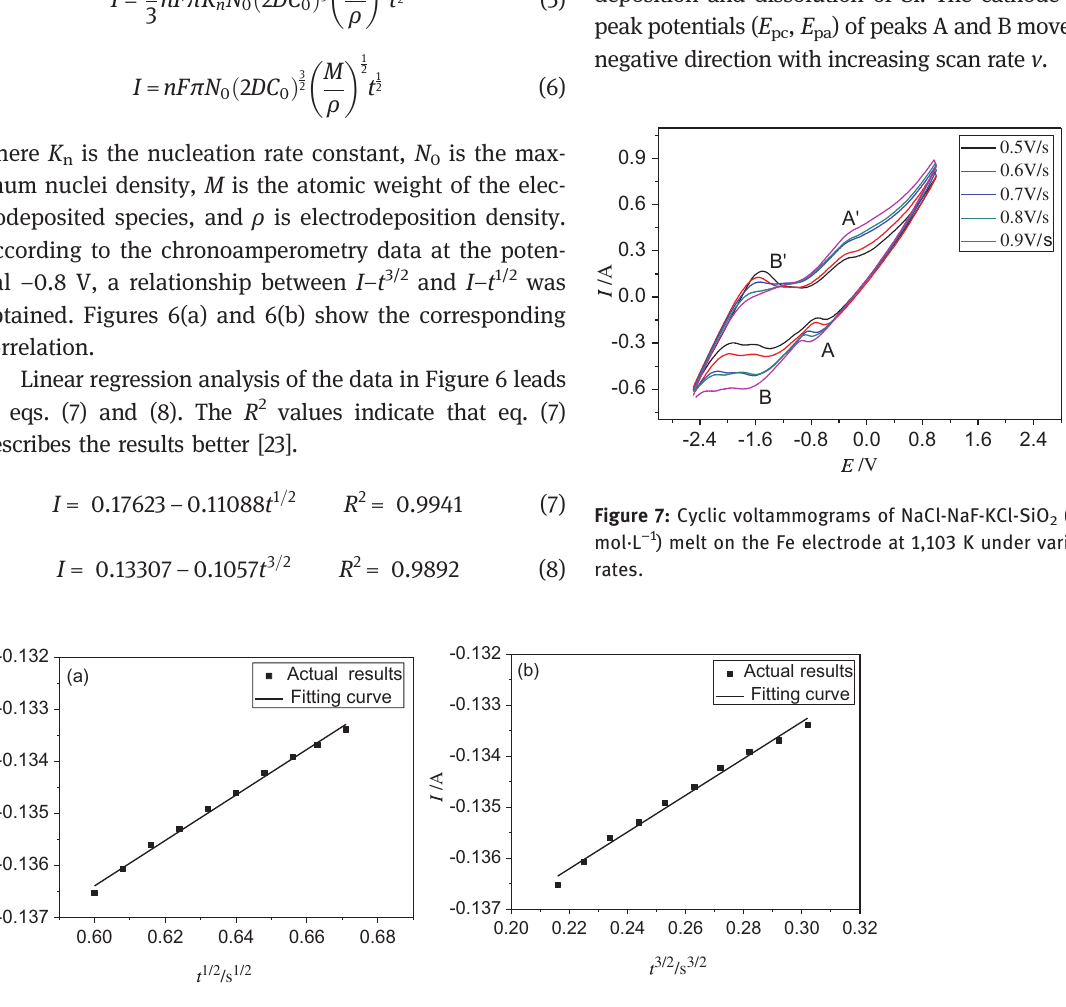
Figure 6: Curves of (a) I – t 1/2 and (b) I – t 3/2 on a Fe electrode in NaCl-NaF-KCl-SiO 2 ( c SiO2 = 0.177 mol·L − 1 ) melt at 1,103 K.